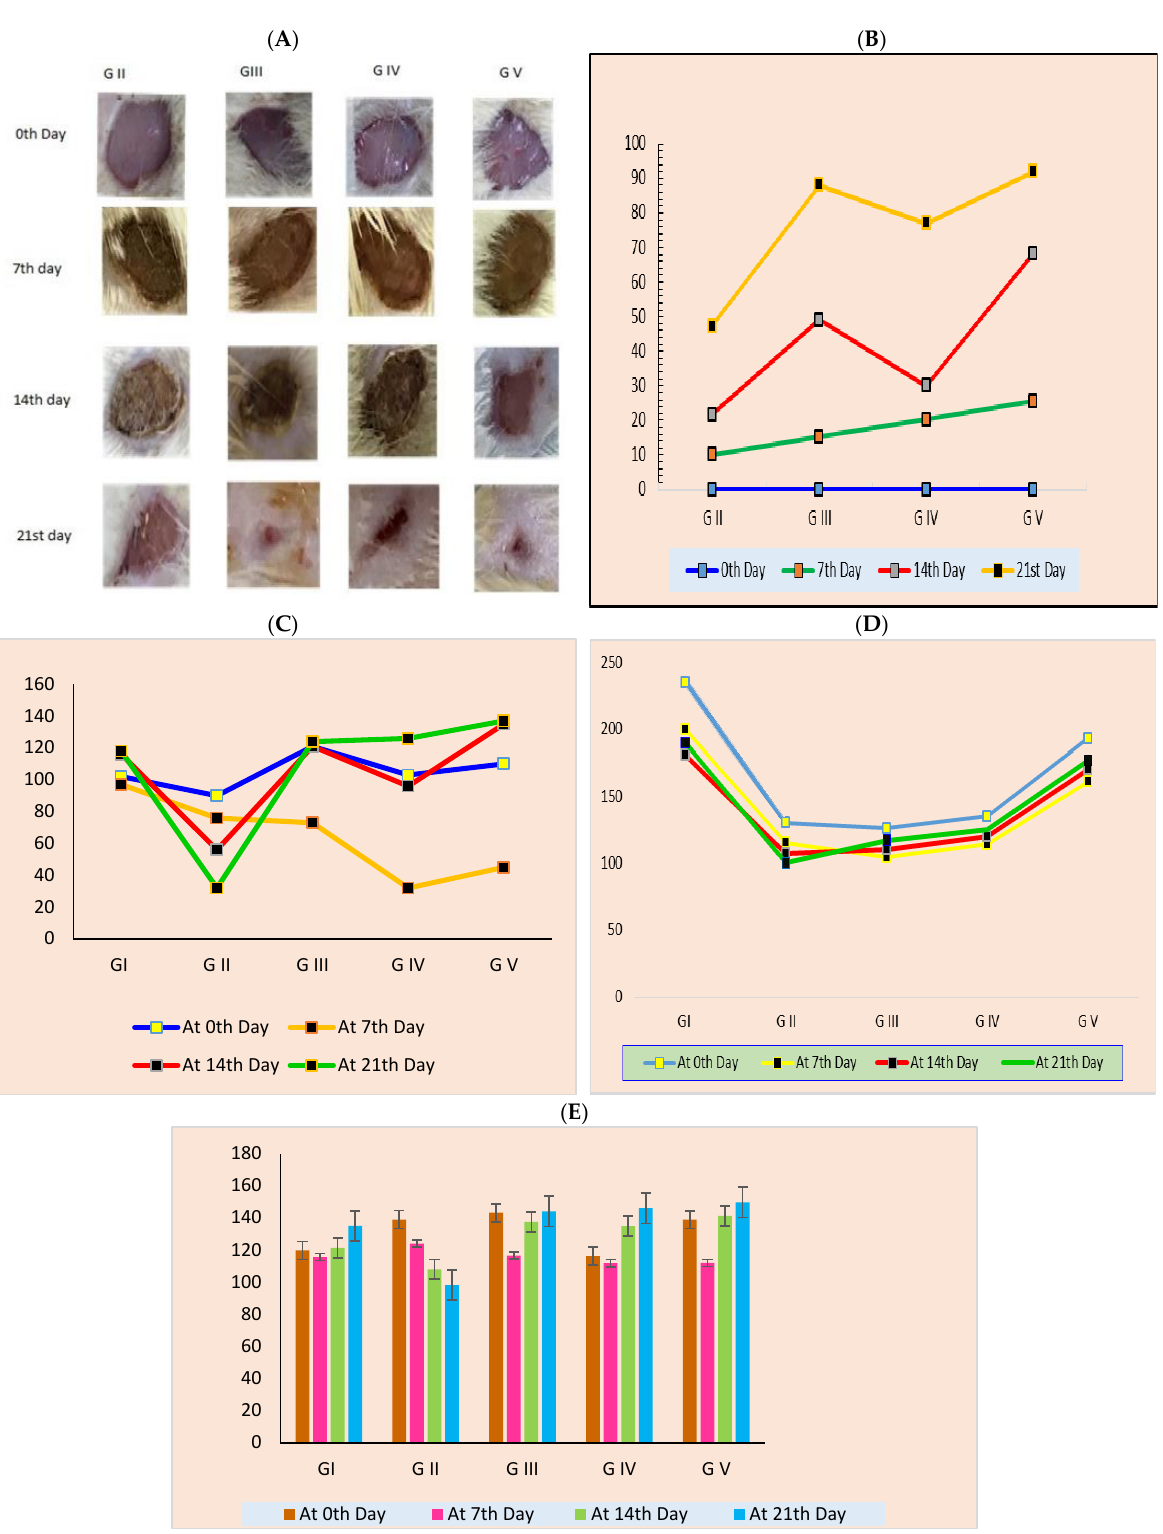
Figure 10. Photographs of wound healing process at different time intervals for different groups ( A , B ), effect of drugs on food intake of normal and wound induction rates ( C ), effect of drugs on water intake of normal and wound induction rates ( D ), effect of drugs on body weights of normal and wound induction rates ( E